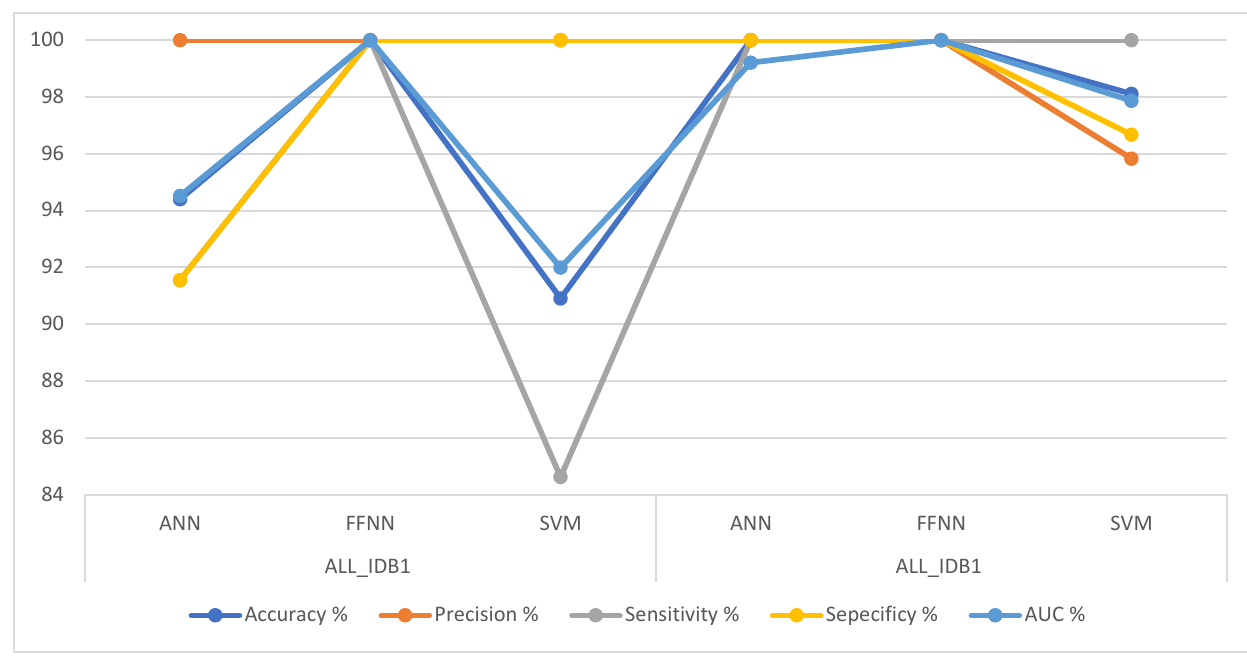
Figure 20. Performances of all the ANN, FFNN and SVM algorithms for the ALL_IDB1 and ALL_IDB2 datasets.